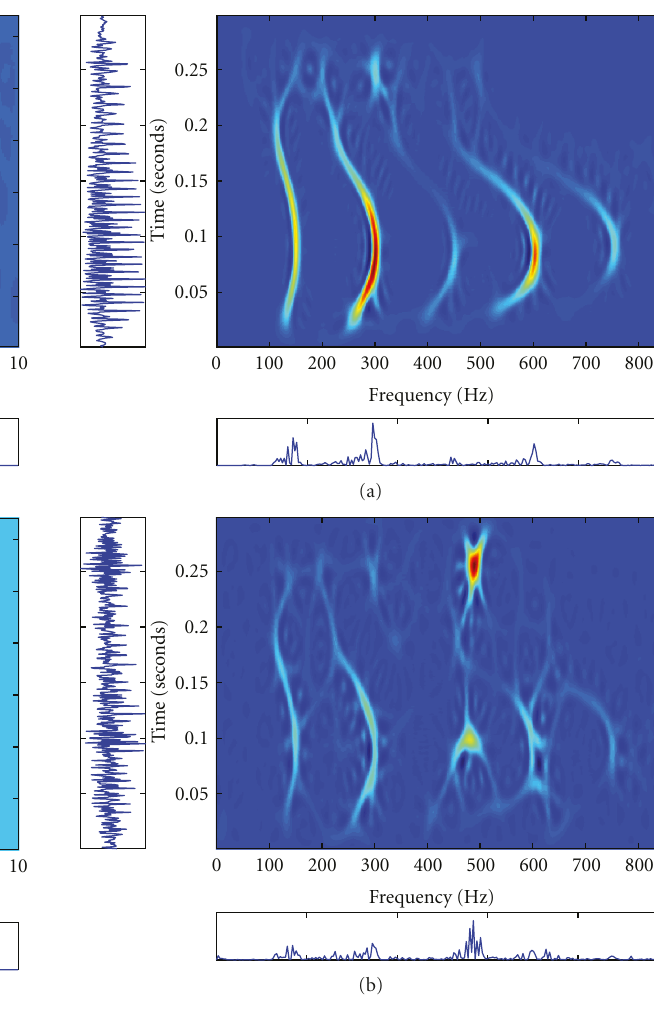
Figure 10: Speech segment (recorded spoken word) in 20dB (a) and 0 dB (b) of babble